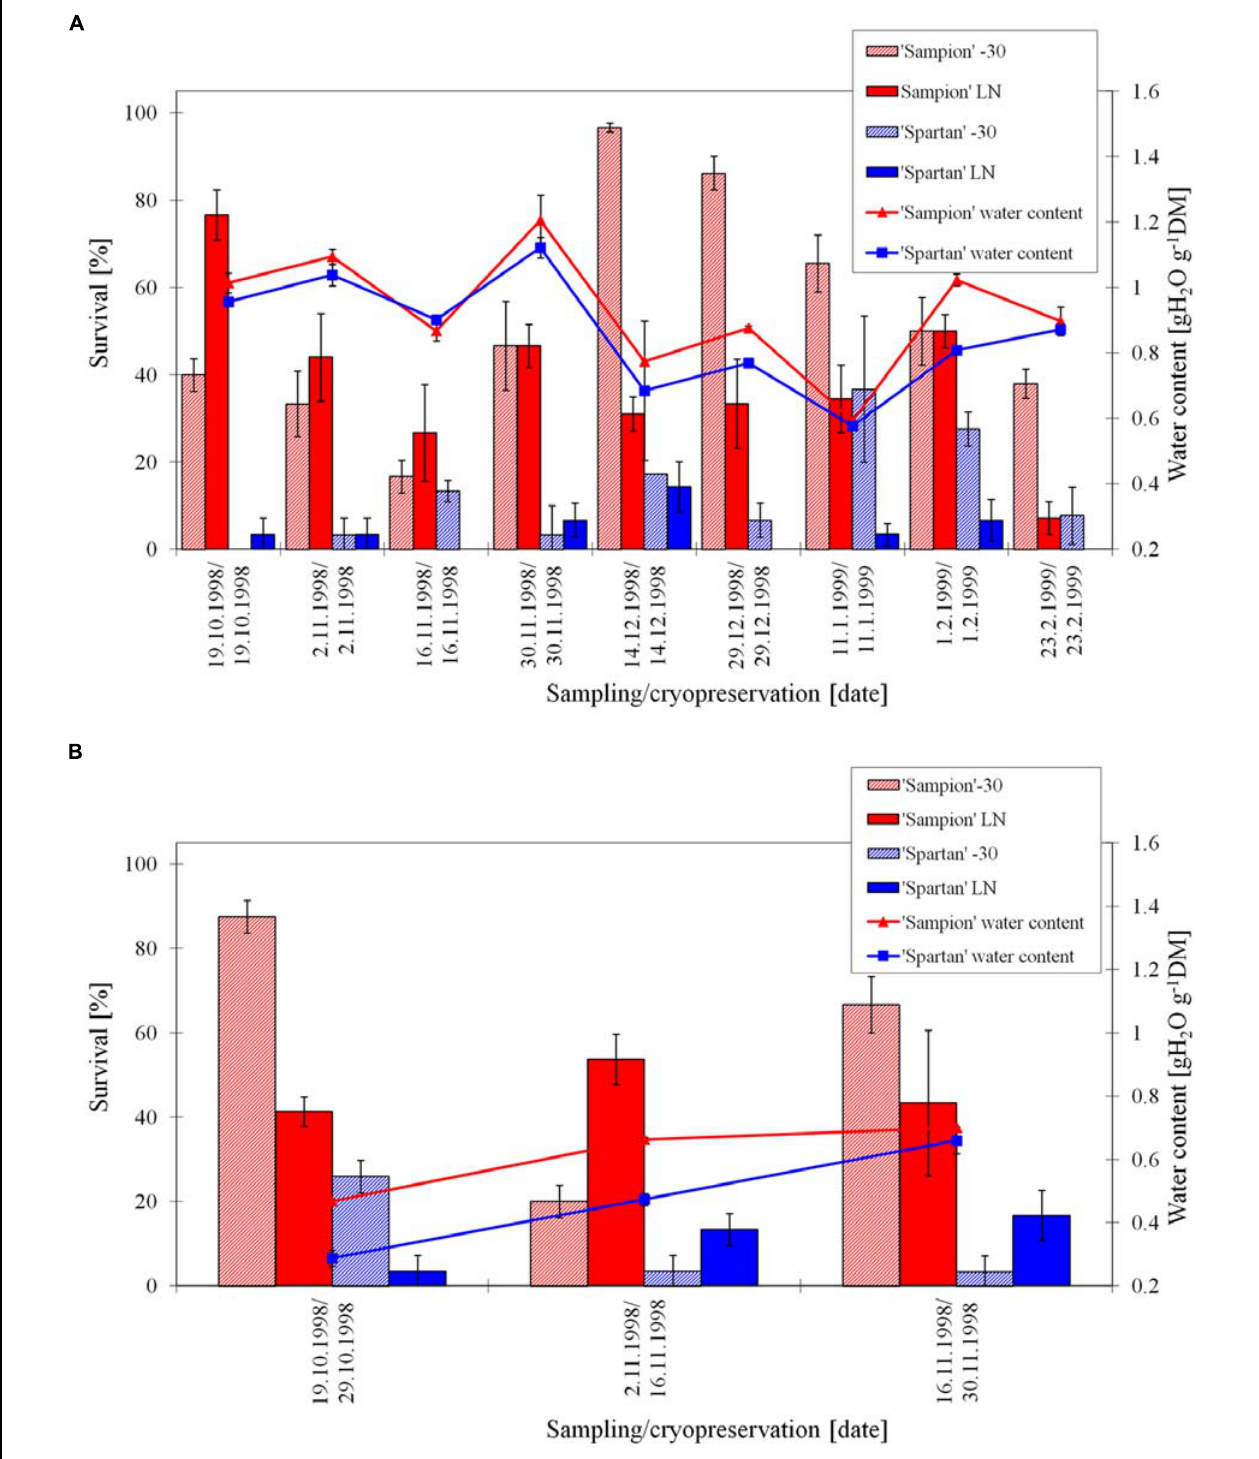
FIGURE 4 | Survival and water content of non-dehydrated (A) and dehydrated (B) vegetative buds of apple cultivars ‘Sampion’ and ‘Spartan’ (B) in the seasons of 1998/1999. Non-dehydrated (ND) variant was cryopreserved immediately after sampling from the orchard. Dehydrated (D) variant was cryopreserved after frost dehydration of at least 1 week at –4 ◦ C. Survival was evaluated after the first step of cryopreservation protocol at –30 ◦ C (–30), and after the second step, reaching the liquid nitrogen (LN) temperature. Survival was tested by examination of oxidative browning of tissues on the longitudinal cut of the bud. Water content was measured immediately before cryopreservation procedure. Bars indicate SD ( p <